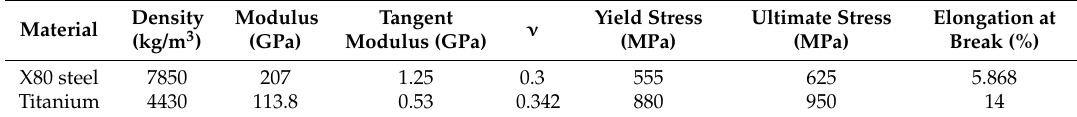
Table 2. Properties of the materials for the steel riser and liner of composite riser.